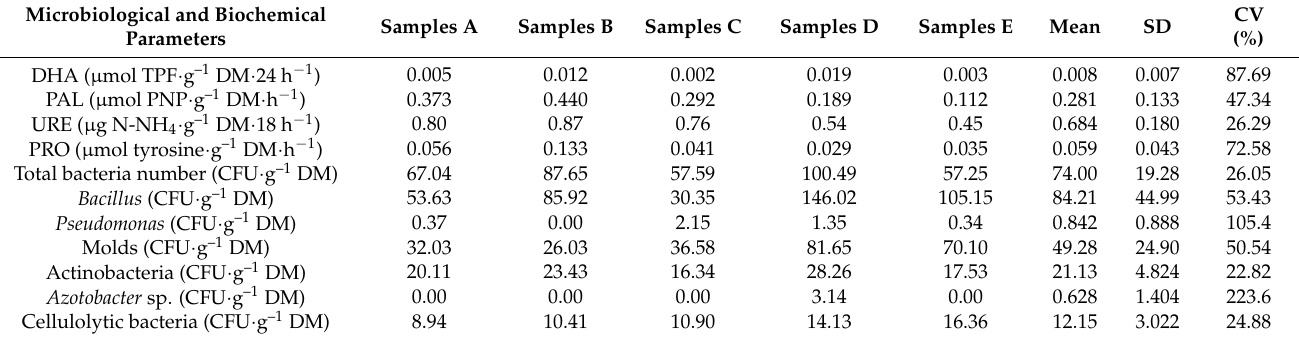
Table 2. The number of selected microorganisms and the enzymes activity in the tested organic materials. Microbiological and Biochemical Parameters